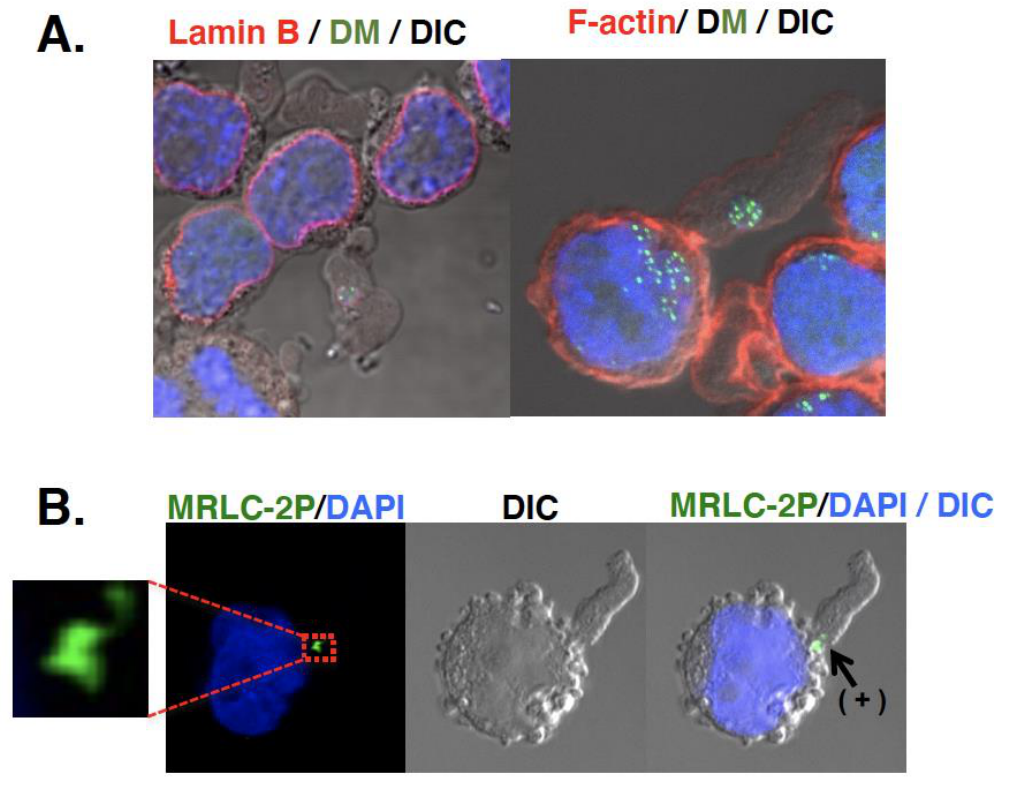
Figure 4. Possible involvement of cytoplasmic bleb in the elimination of extrachromosomal circles. Large cytoplasmic bleb (protrusion) induced by fresh serum could entrap the micronuclei [31]. The bottom of such bleb was constricted (grayscale DIC image), where actin (red in ( A )) and phosphorylated myosin (MRLC-2P; green in ( B )) was located (noted as “+” in ( B )) just like a contractile ring during the cytokinesis. DMs were detected in green by Lactose repressor-GFP binding to lactose operator sequence on DMs [29]. These are unpublished images.